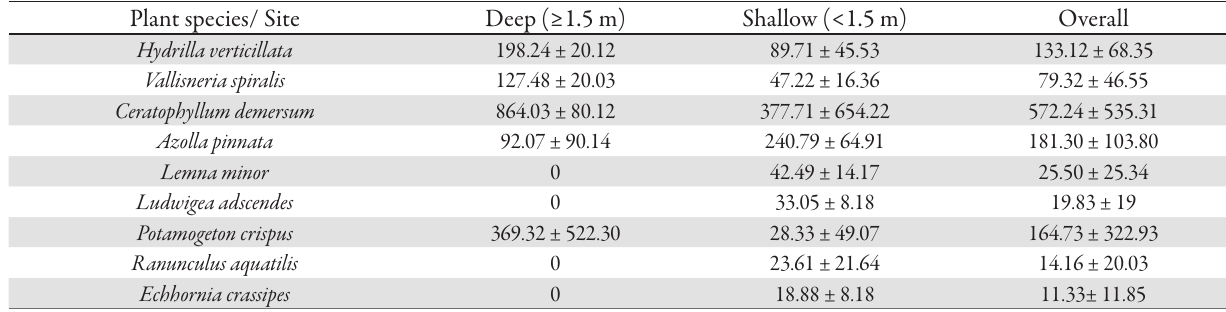
Fig. 2. Species richness, evenness and shannon-weaver diversity index for Tab. 3. Status of aquatic vegetation across various sampling sites